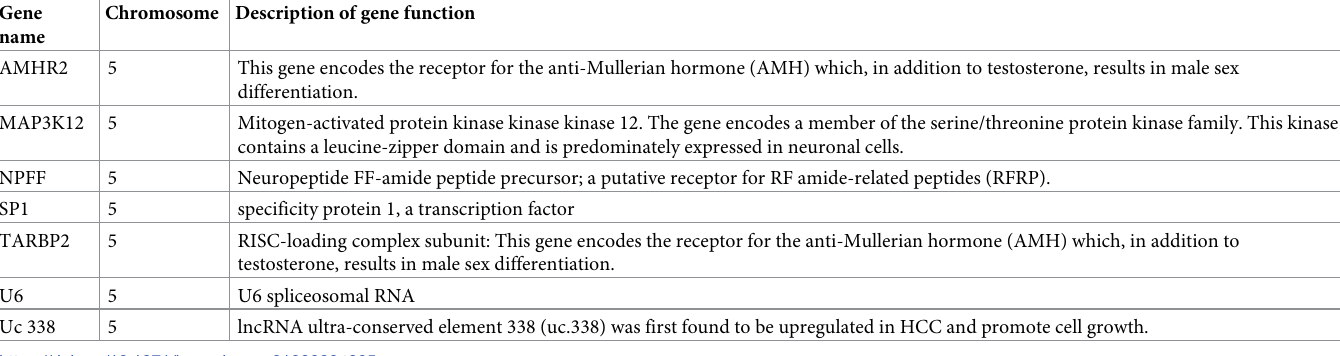
Table 5. Genes located in regions under high differential selection and shared between Busia, Homabay and wild African pig